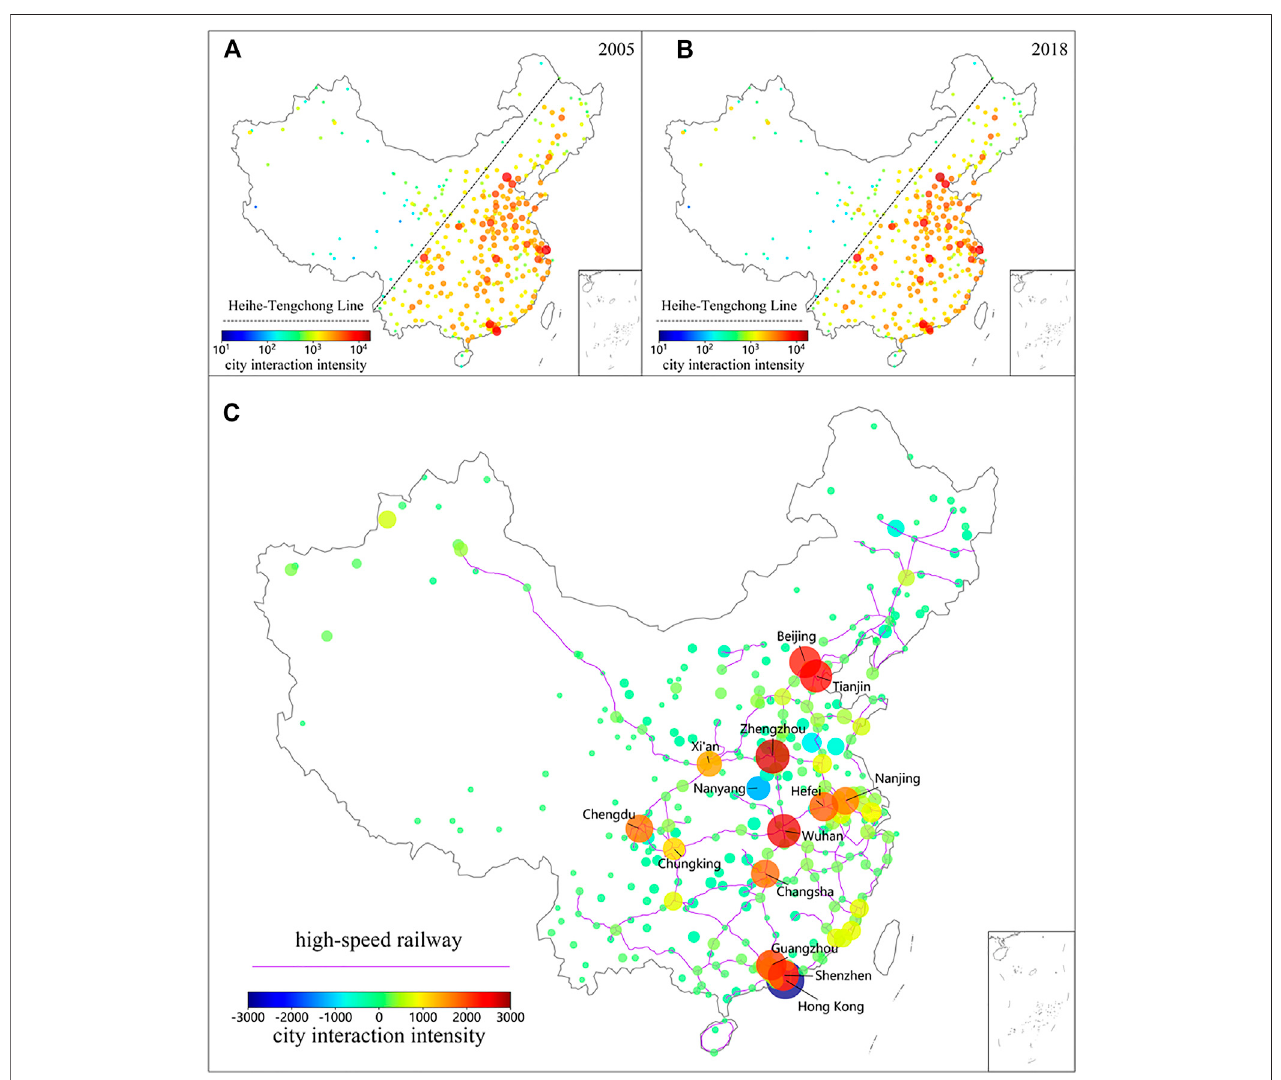
FIGURE 5 | City interaction intensity and the difference between city interaction intensity in 2005 and that in 2018. (A) 2005 and (B) 2018 Chinese city interaction intensity. The dotted line is the Heihe-Tengchong line and each circle represents a city. The color and size of the circle indicate the city interaction intensity. (C) The difference between city interaction intensity in 2005 and that in 2018. Each circle represents a city and the size of the circle represents the absolute value of the difference value.